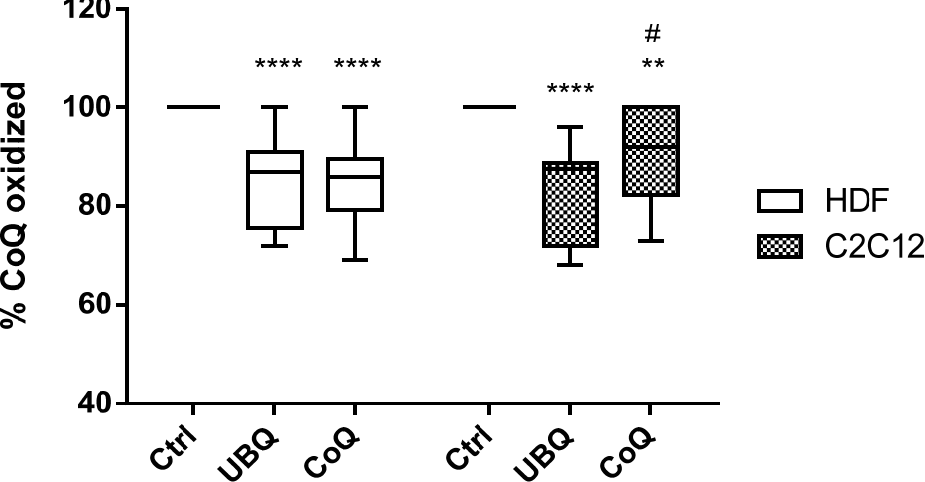
Figure 5. Cellular CoQ 10 oxidized levels in human dermal fibroblasts (white clear box plots) and mouse skeletal myoblasts (small dot box plots) treated with medium (controls, Ctrl), enriched LDL derived from the plasma of subjects supplemented with Ubiqsome (UBQ) or crystalline CoQ 10 (CoQ) at the same concentration of CoQ 10 0.5 µg/mL for 24 h. Data are expressed as boxes and bar plots (median value) ( n = 3). Statistical significance was calculated using two-way Anova with Tukey’s multiple comparisons tests compared with the control cells (Ctrl) (** p < 0.01, **** p < 0.0001) or crystalline CoQ 10 (CoQ) (# p <0.05).